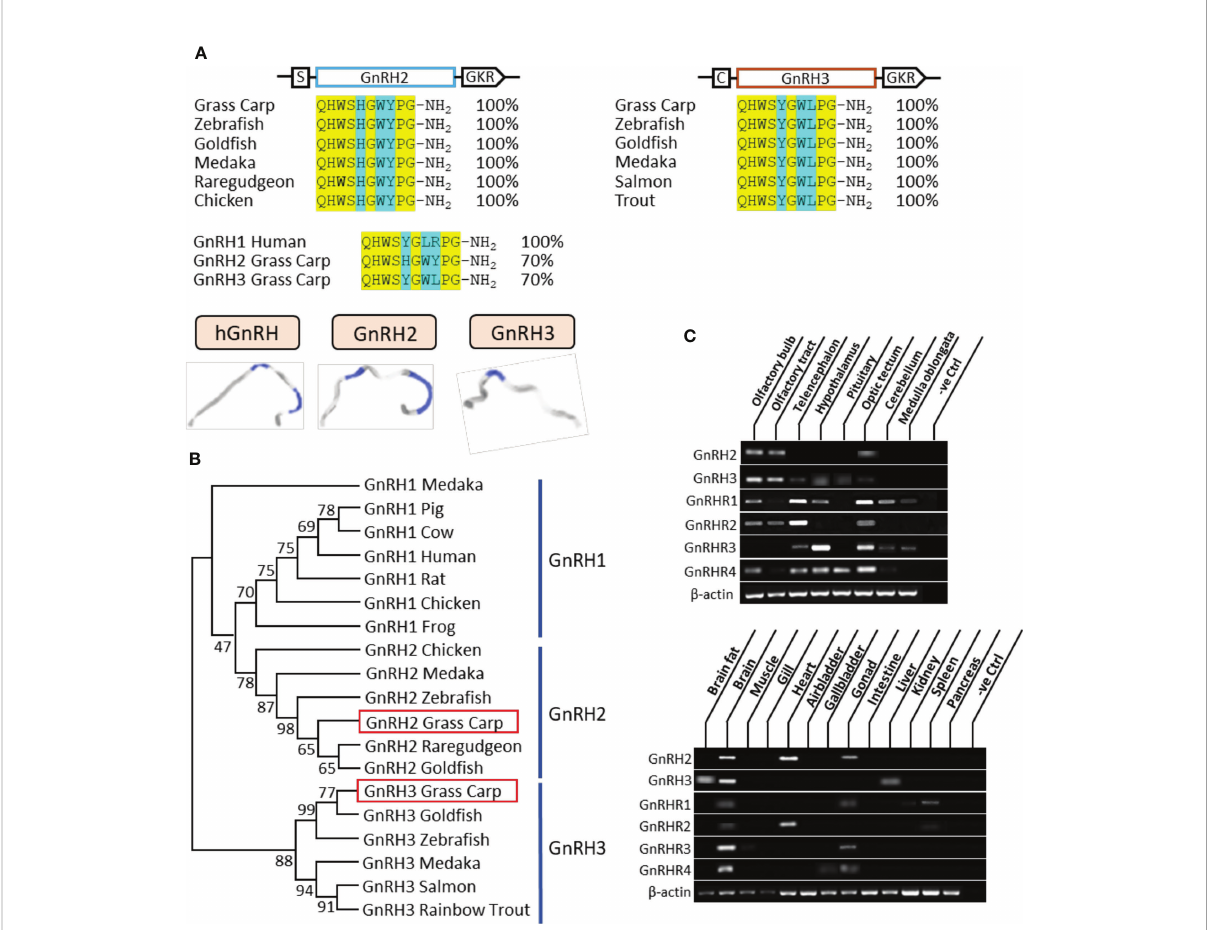
FIGURE 1 Sequence analysis and tissue distribution of grass carp GnRHs/GnRHRs. (A) The mature peptide sequence alignment of GnRHs. The conserved amino acid sequences are processed into a yellow background, whereas the different amino acid residues compared with human GnRH1, grass carp GnRH2, and GnRH3 are marked in blue background. (B) Phylogenetic analysis of GnRHs from mammal or non-mammal vertebrates are generated with the neighbor-joining method (MEGA 6.0); grass carp GnRH2 and GnRH3 are highlighted into the red frame. (C) Tissue distribution of GnRHs and GnRHRs was detected in grass carp peripheral tissues (on the bottom) and various brain subregions (on the top). Total RNA was extracted, reverse transcribed, and underwent RT-PCR using speci fi c primers; the results have been intercepted and spliced according to corresponding PCR product size. Besides, the transcript level of b -actin was considered as an internal